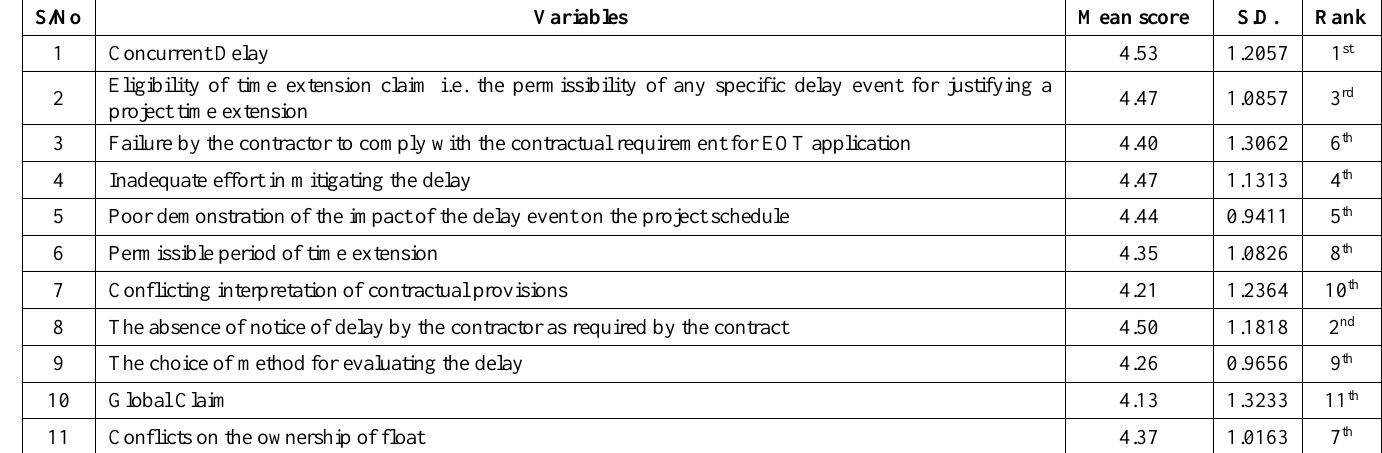
Table 6: Disputed Issues Associated with EoT